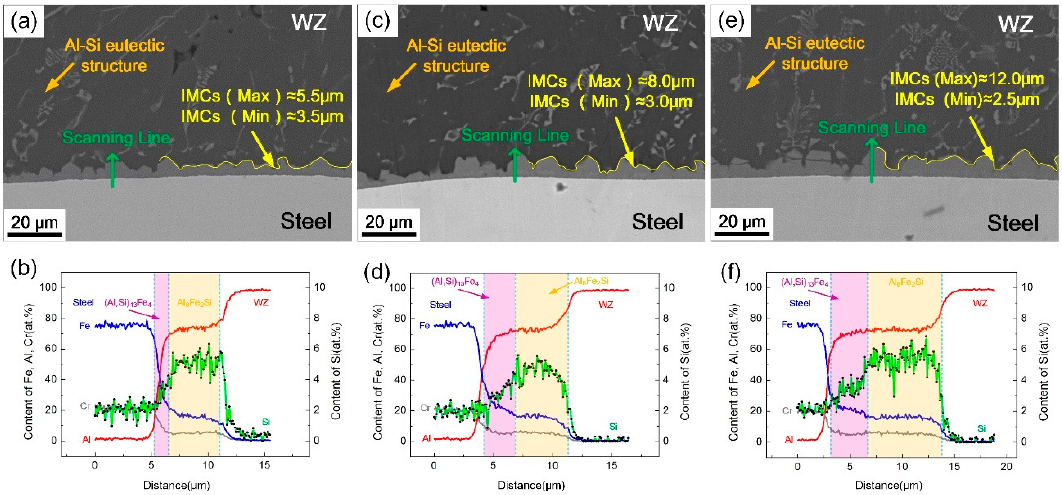
Figure 5. Microstructure and EDS line scanning results of WZ/steel interface at different alternating frequencies: ( a , b ) 2 A, 5 Hz; ( c , d ) 2 A, 10 Hz; ( e , f ) 2 A, 15 frequencies: ( a – b ) 2 A, 5 Hz; ( c – d ) 2 A, 10 Hz; ( e – f ) 2 A, 15 Hz.